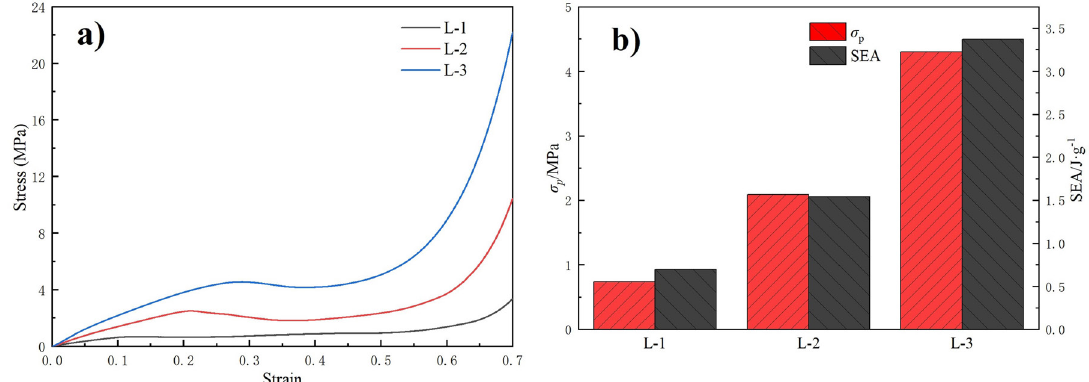
Figure 7. a) Stress-strain curves of different strut distance, b) Platform stress and SEA of different strut distance.